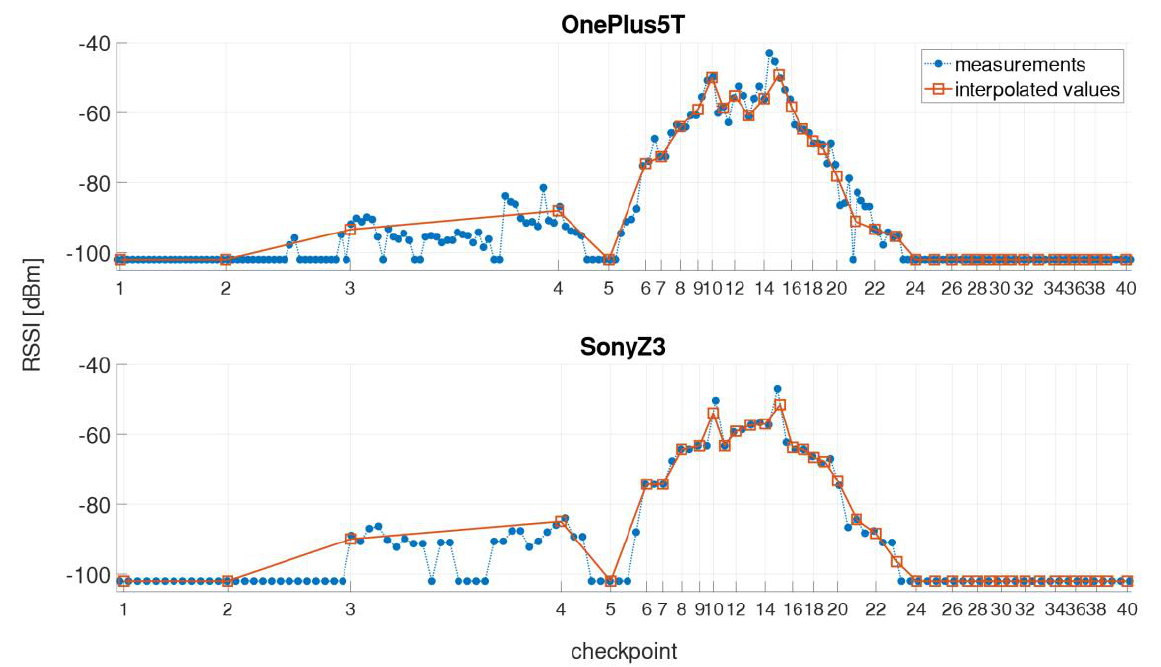
Figure 3. Linear interpolation of the kinematic measurements for the two smartphones ( top ) OnePlus 5T and ( bottom ) Sony Z3 which measured simultaneously. Table 4. Average scan durations and sensed AP signals per scans for the six available